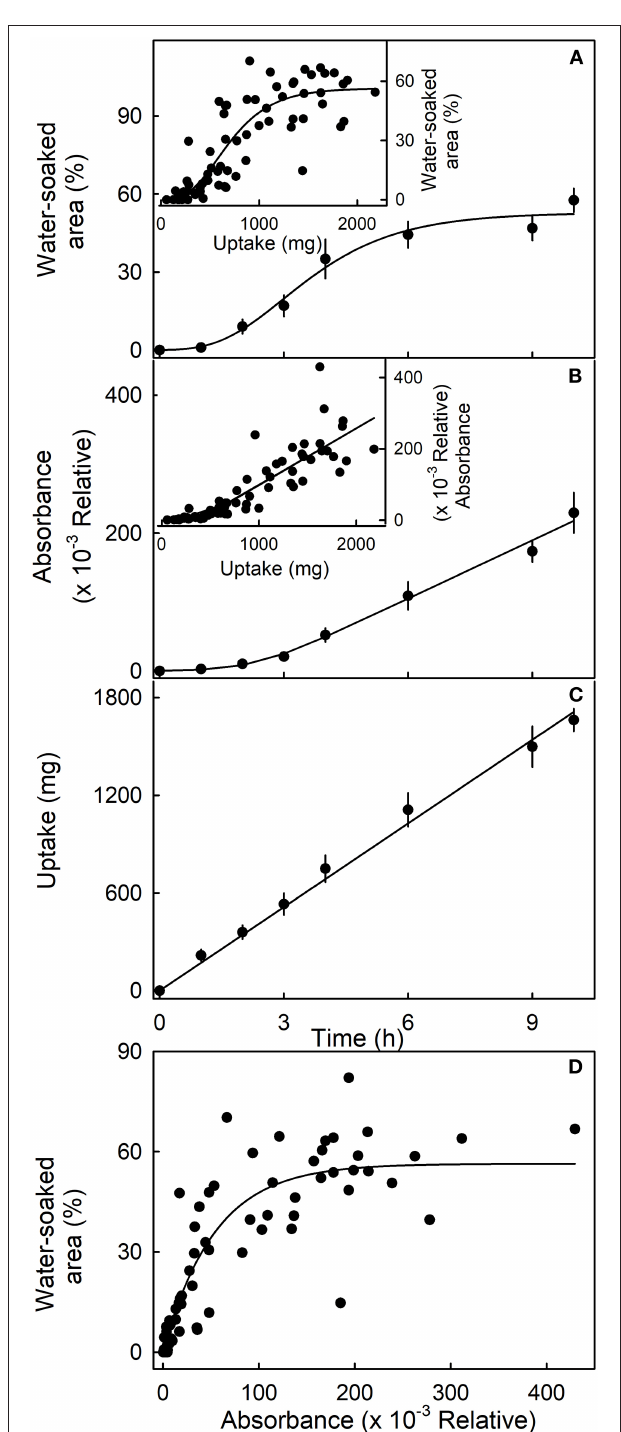
FIGURE 4 | Time course of (A) change in water-soaked area, (B) change in anthocyanin leakage as indexed by absorbance of the incubation solution at 520nm, and (C) water uptake of strawberries incubated in deionized water. Insets. Relationship between the water-soaked area (inset in A ), the change in absorbance (inset in B ), and water uptake. (D) Relationship between the water-soaked area and the leakage of anthocyanins as indexed by the change in